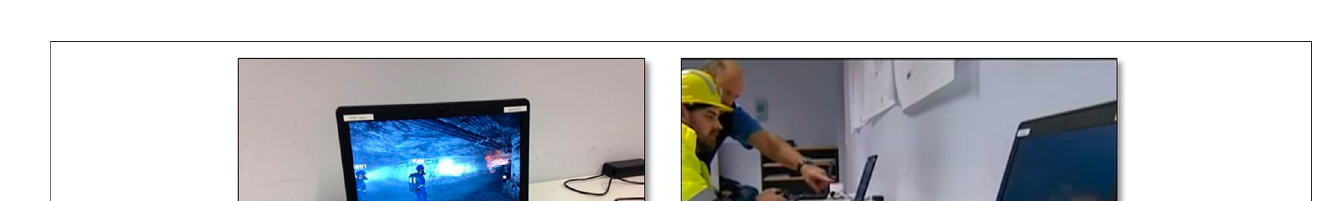
FIGURE 2 | Empty 360 ° immersive theater (360-VR).